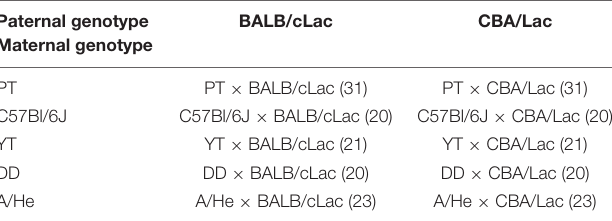
TABLE 1 | The experimental design for identification of inheritance of the murine tendencies in dominance and subordination. Paternal genotype Maternal